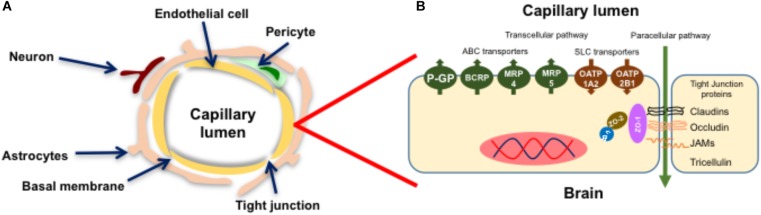
Structure of the blood-brain barrier. The BBB is a neurovascular unit comprised of endothelial cells, a basal membrane, pericytes, astrocytes and neurons (A). Brain endothelial cells (BECs) express ABC/SLC transporters and high levels of Tight Junction (TJ) proteins that confer the barrier properties of the BBB (B). Figure adapted from Abbott et al. (2010) and O’Brien et al. (2012) with permission from their publishers.